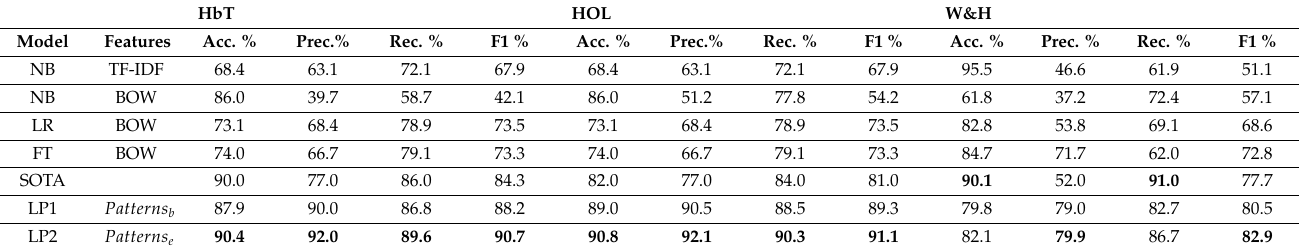
Table 7. Results obtained for Twitter datasets when using different approaches. Top performance highlighted in bold. HbT HOL W&H Model Features